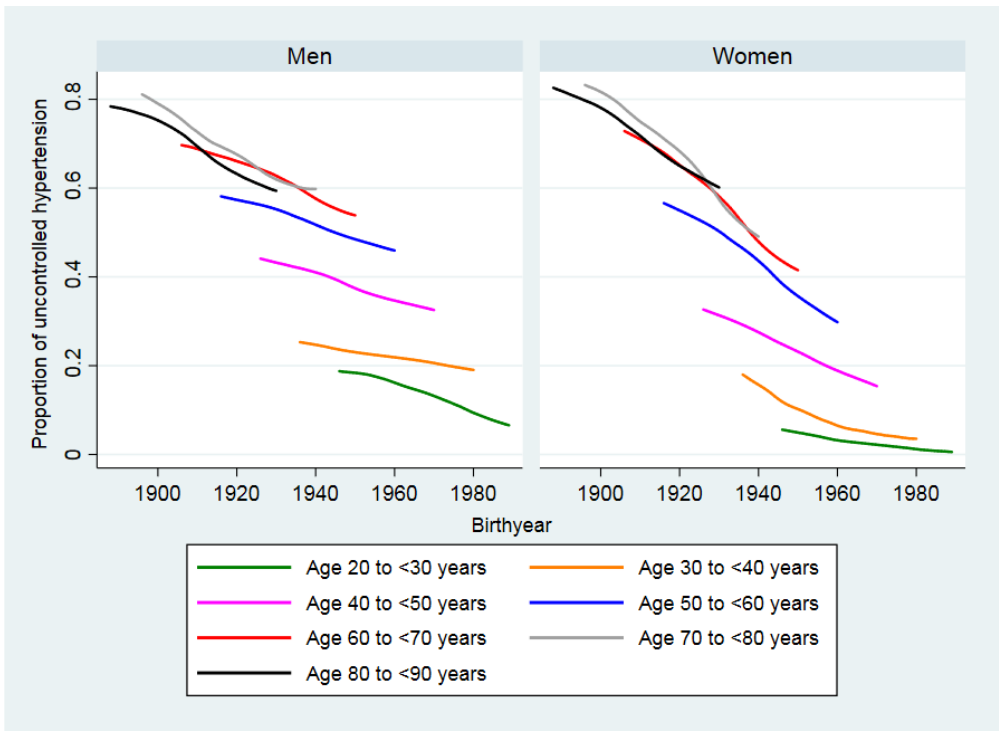
Figure 2. Uncontrolled hypertension in Japan by birth year (1886 to 1989) and sex for birth